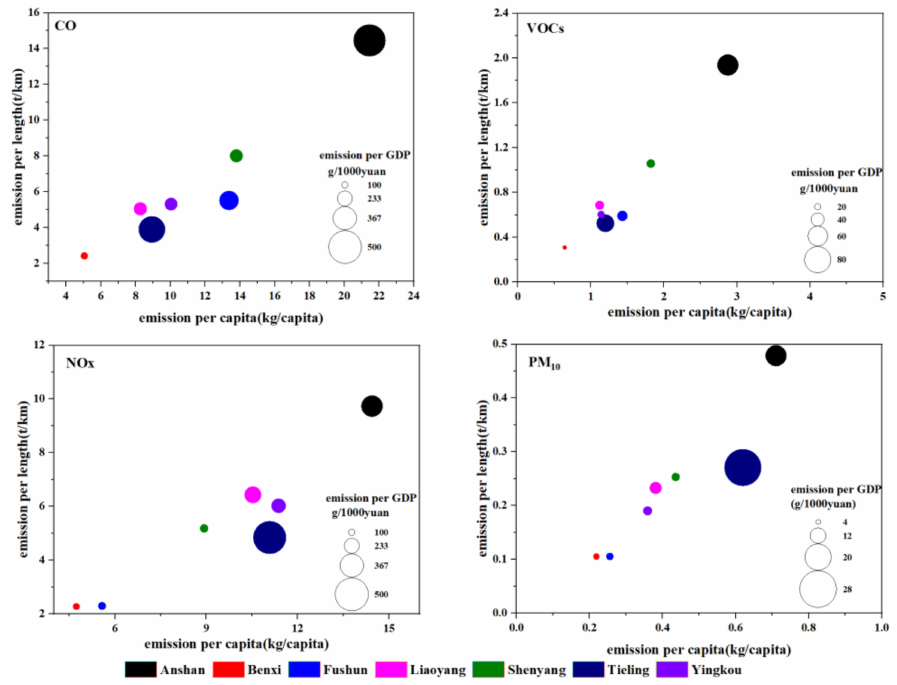
Figure 6. Emissions intensity, emissions per capita, and emissions per GDP of cities in the CLUA region during 2018 (GDP: gross domestic